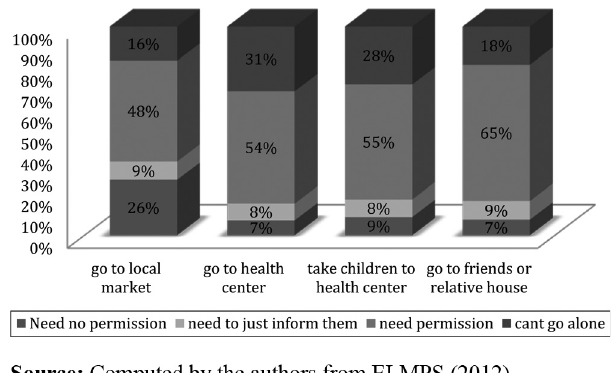
Figure 2. Distribution